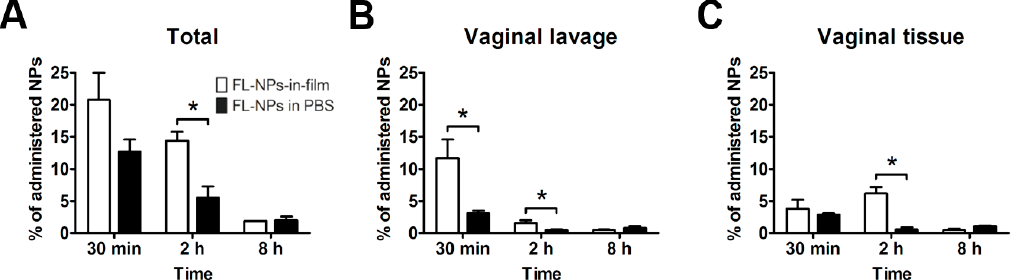
Figure 3. Schematic representation of targeted siRNA-loaded NPs formulated into a biodegradable film for targeting siRNA delivery into HLA-DR+ dendritic cells, using a co-culture cell model. Targeted siRNA-loaded NPs are homogeneously dispersed in a biodegradable film and, upon administration, the film is expected to disintegrate within the vaginal lumen, allowing siRNA-loaded NPs to penetrate across the vaginal mucosa and deliver siRNA in a targeted manner to HLA-DR+ mKG-1 dendritic cells. Reprinted with permission from [110]. Copyright (2015) American Chemical Society.